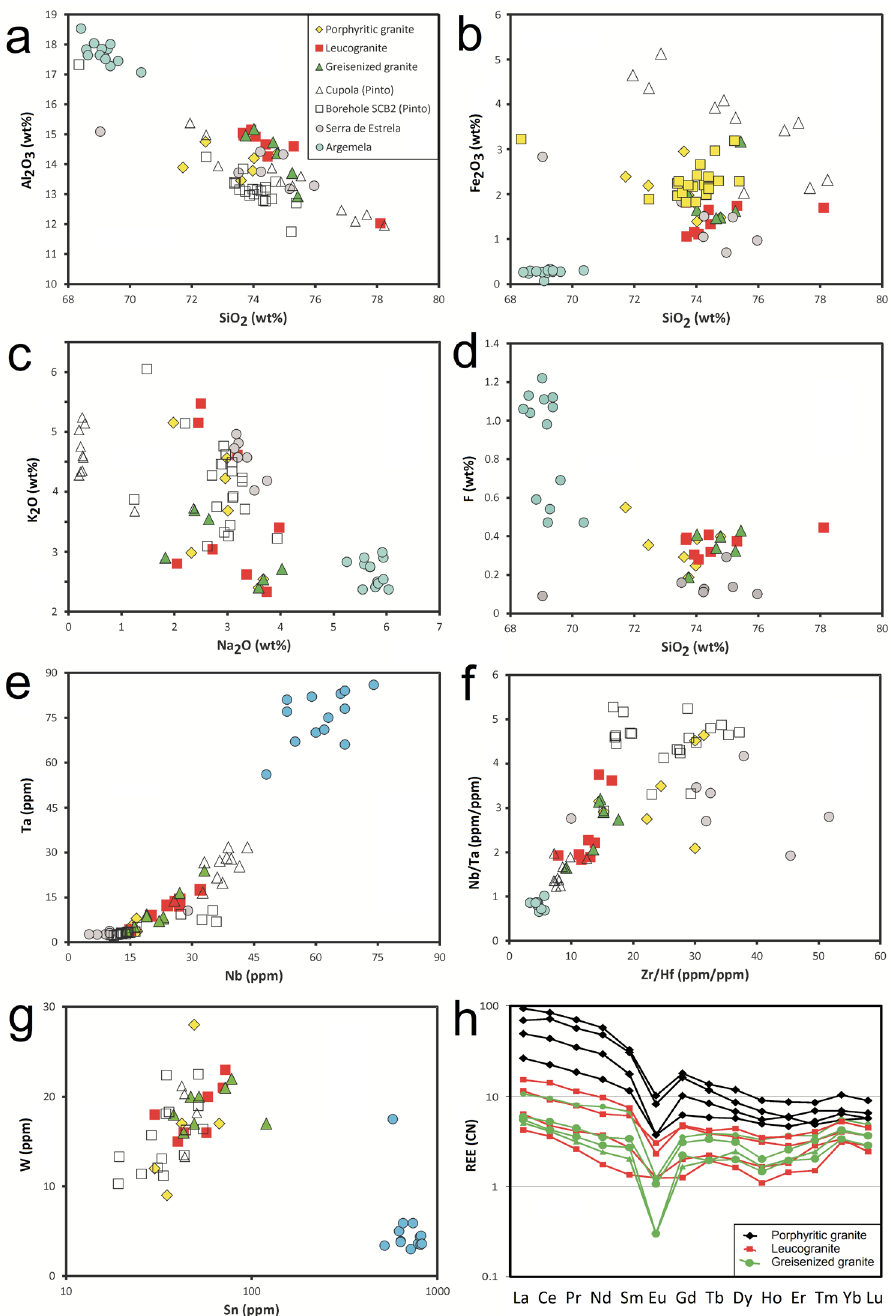
Figure 5. Bulk chemical composition of granites from Panasqueira: ( a ) SiO 2 vs. Al 2 O 3 ; ( b ) SiO 2 vs. Fe 2 O 3 tot; ( c ) Na 2 O vs. K 2 O; ( d ) SiO 2 vs. F; ( e ) Nb vs. Ta; ( f ) Zr/Hf vs. Nb/Ta; ( g ) Sn vs. W; ( h ) distribution curves of chondrite-normalized REEs [34]. Analyses from Panasqueira made by Pinto [20] and compositions of typical samples from the Serra Estrela pluton [22] and Argemela stock [23] are shown in Figures a–g for comparison.